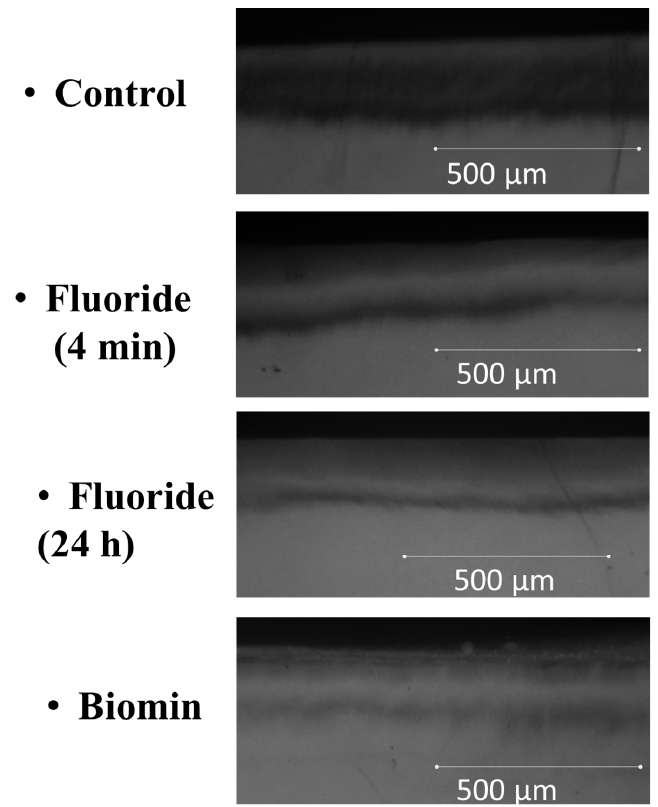
Figure 2. Transverse Micro Radiography (TMR) images for the four groups.